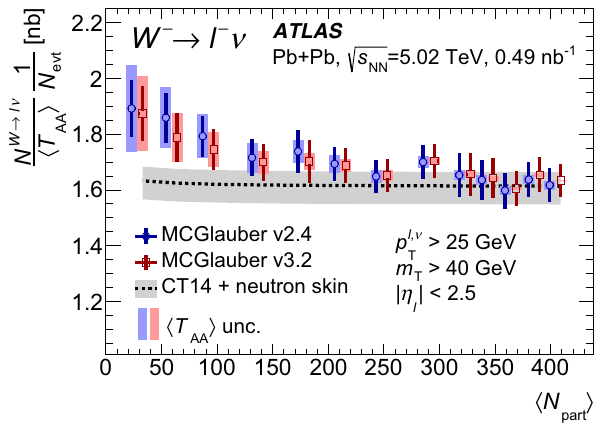
Fig. 13 Comparison of normalised production yields for W + (left) and W − (right) bosons as a function of (cid:4) N part (cid:5) for geometric param- eters obtained with the MCGlauber code v2.4 and v3.2. The dashed lines show predictions calculated using the CT14 NLO PDF set which incorporate the neutron-skin effect evaluated using the separate radial distributions for protons and neutrons provided by the MCGlauber code